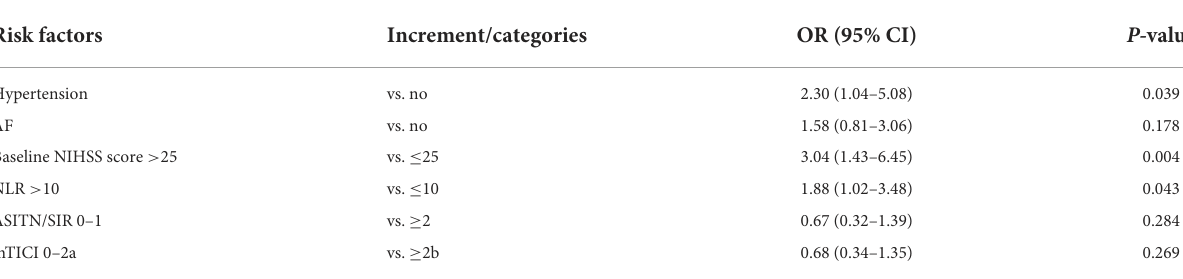
TABLE 2 Multivariate analysis of predictors of PH after endovascular